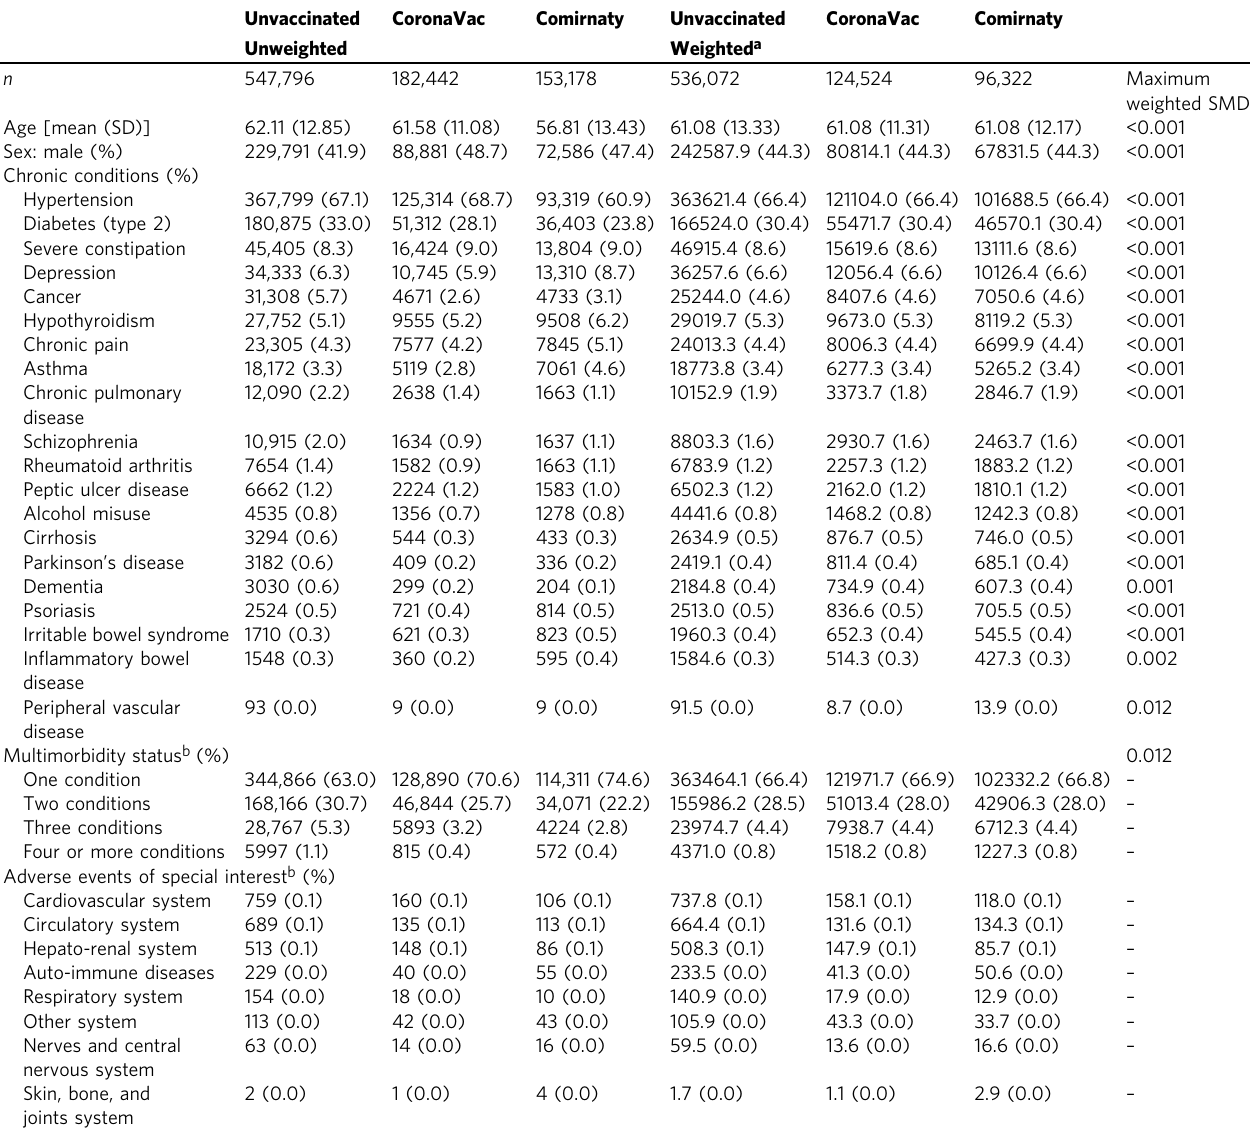
Table 1 Unweighted and weighted cohort characteristics ( N = 883,416) of unvaccinated individuals, CoronaVac, or Comirnaty recipients.